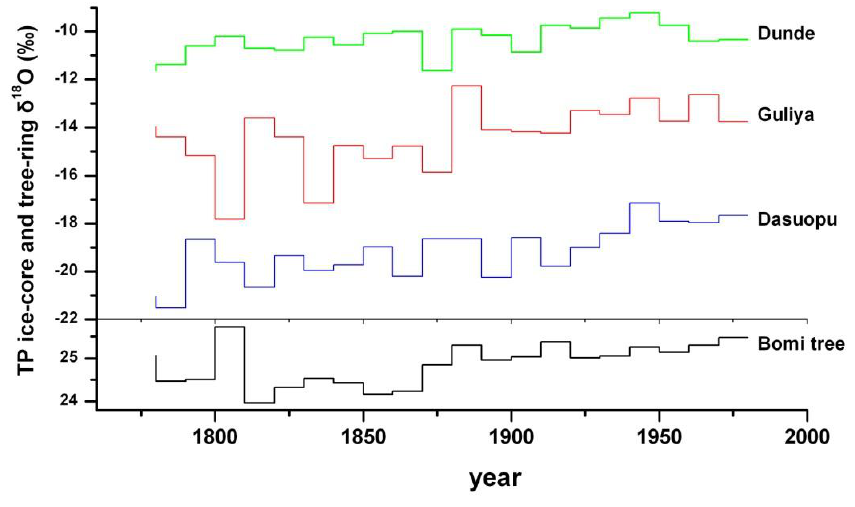
Fig. 4. Comparison of tree-ring δ 18 O and ice-core δ 18 O records on Tibetan Plateau (Thompson et al., 1989, 1997,